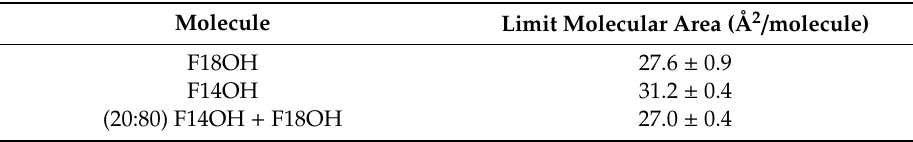
Table 1. Limit molecular areas calculated from the π – A isotherms.